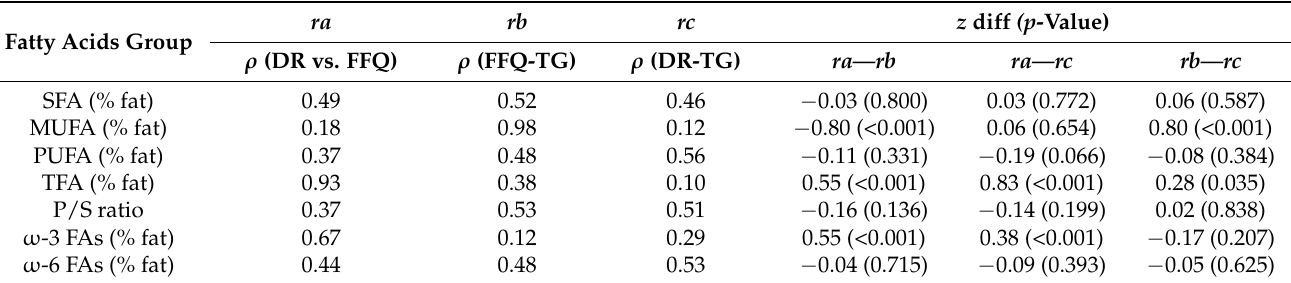
Table 5. Validity coefficients for method of